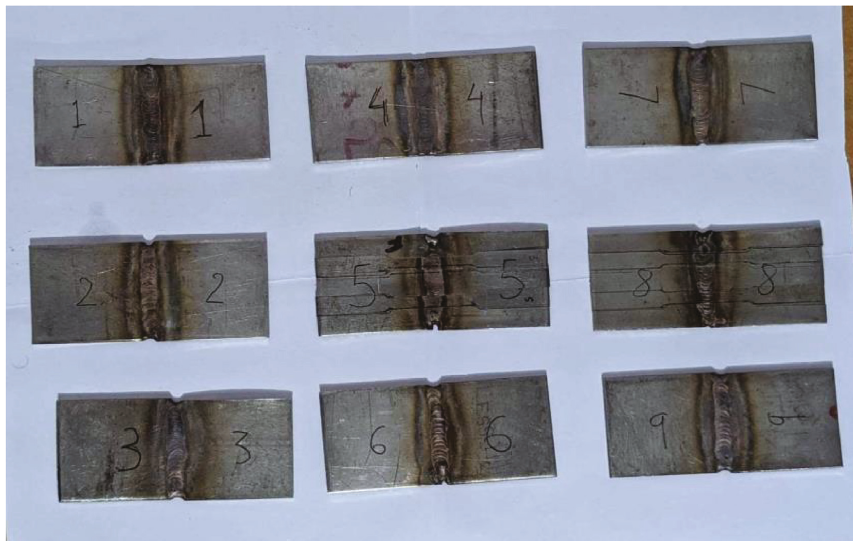
Figure 3: Welded joint after the TIG welding.